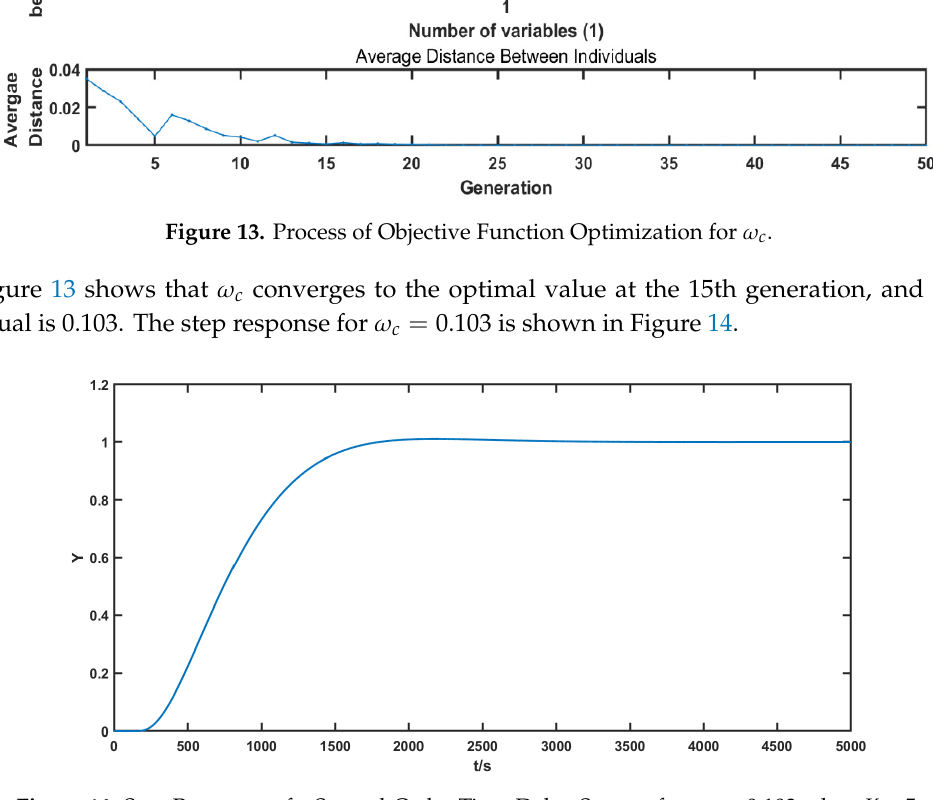
Figure 14. Step Response of a Second-Order Time-Delay System for ω c = 0.103 when K = 5 .